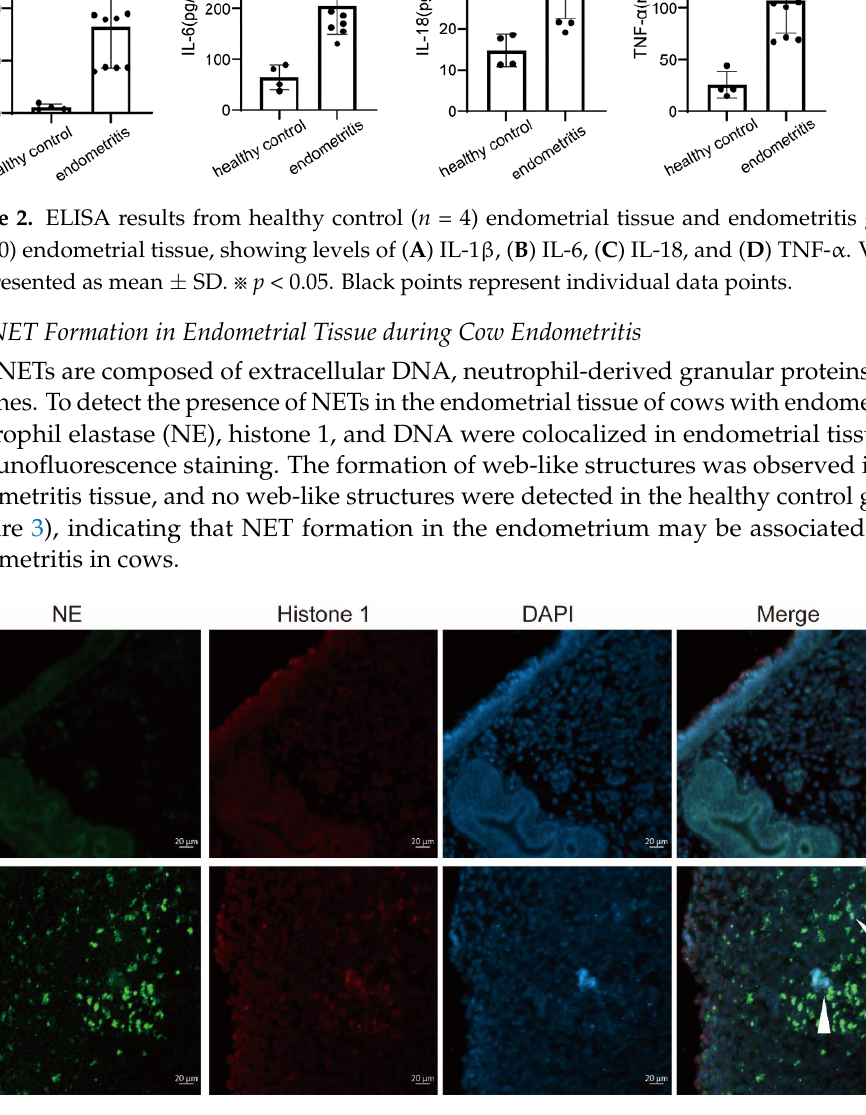
Figure 3. Immunofluorescent staining of NETs was assessed by confocal microscopy in healthy control endometrial tissue and endometritis group endometrial tissue, NE (green), neutrophil elastase; histone 1 (red); DAPI (blue); white arrows indicate neutrophil extracellular traps; white bar = 20 µm; 400× magnification.